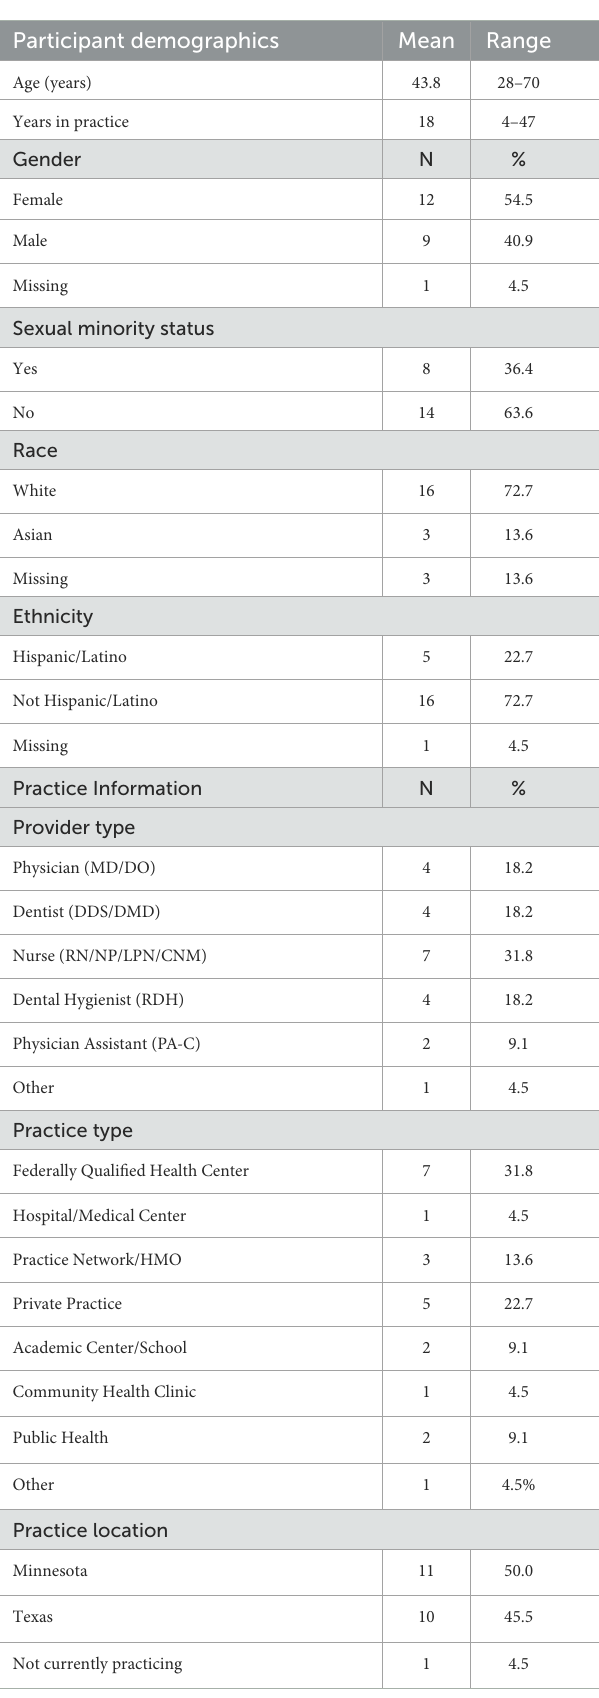
TABLE 1 Participant demographic